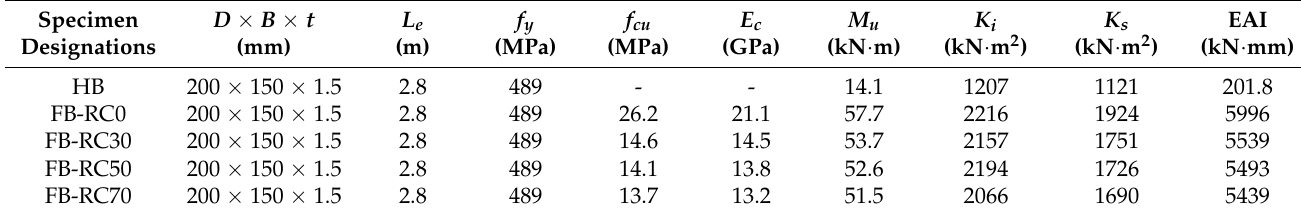
Figure 1. Cold-formed steel C-sections (all dimensions in mm). Table 1. Designations and results of the tested specimens.